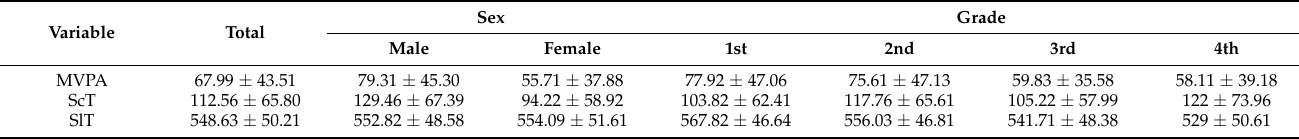
Table 2. Descriptive statistics of the research variables according to sex and grade.